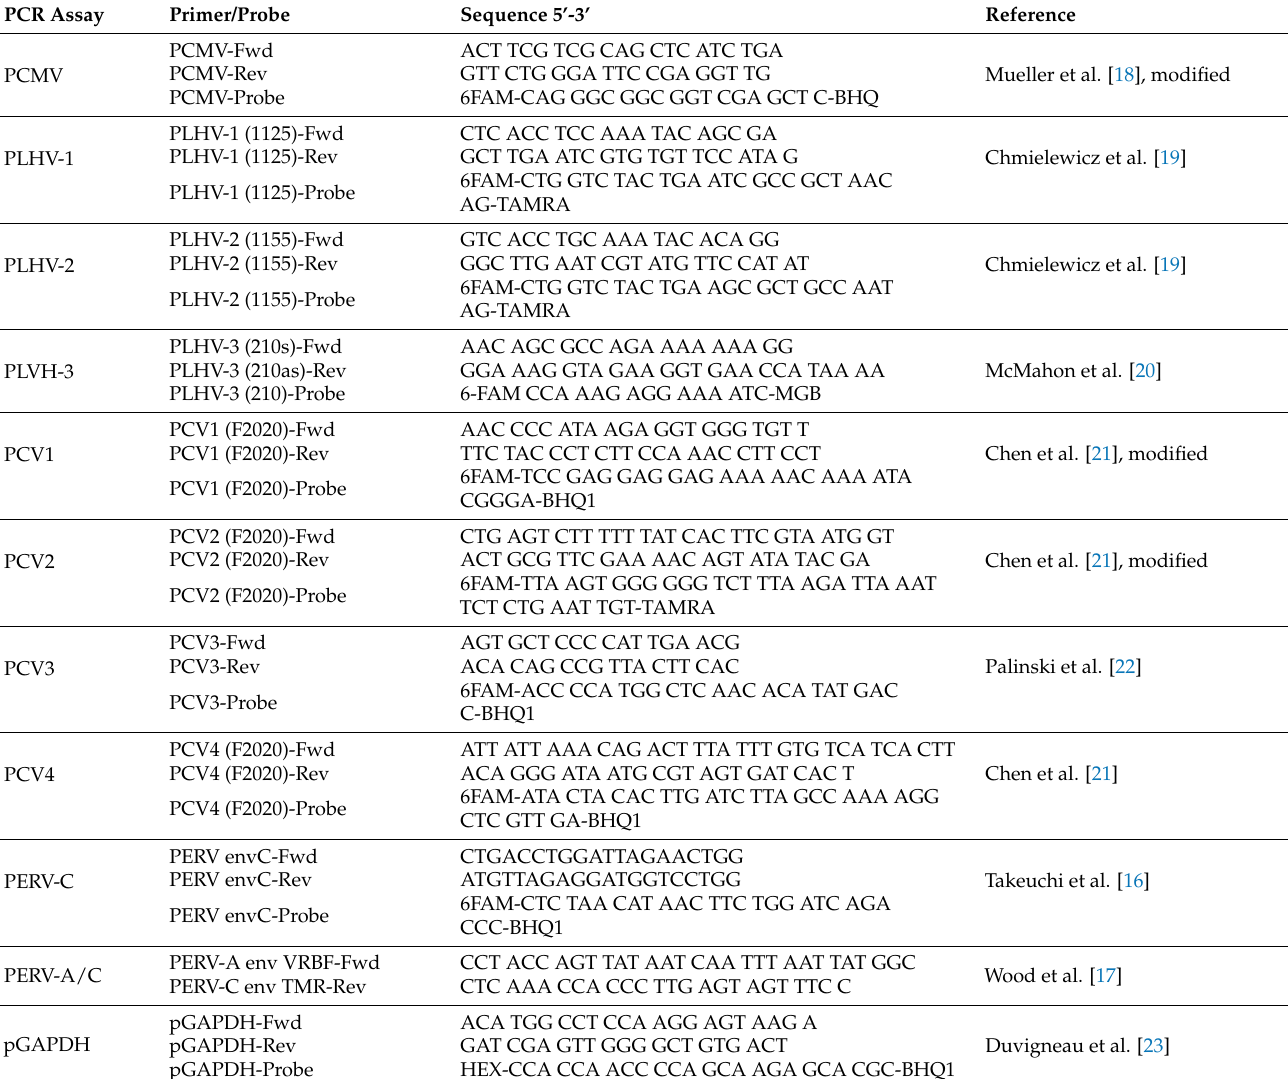
Table 2. Primers and probes used in this